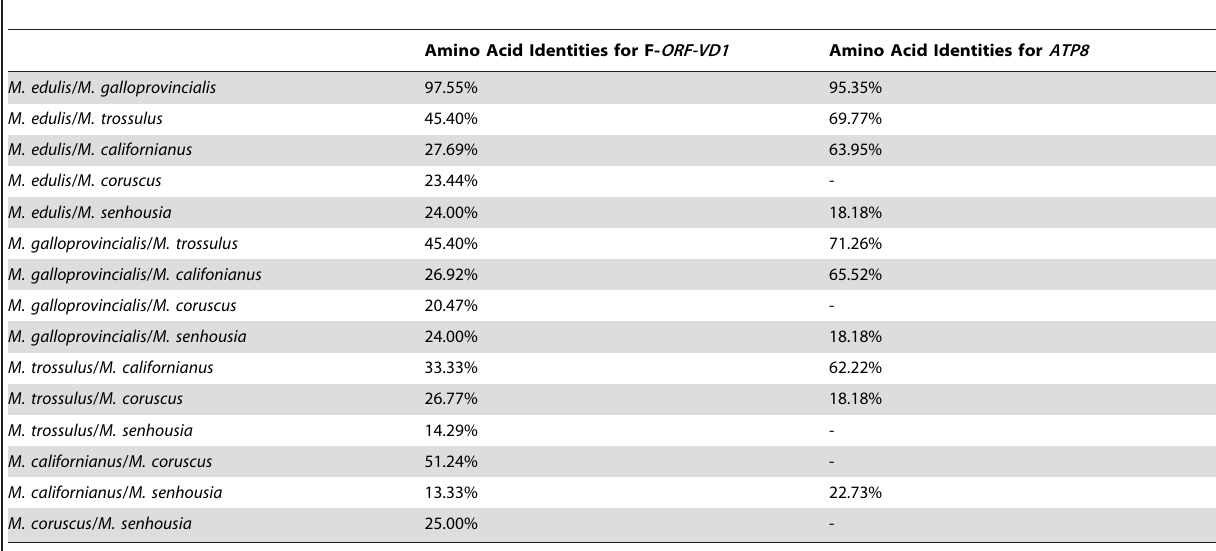
Table 4. Interspecies comparisons in the mytilid F lineage ( Mytilus spp. and Musculista senhousia ) for the fast evolving F- ORF-VD1 & F- ORF and ATP8 genes: % amino acid